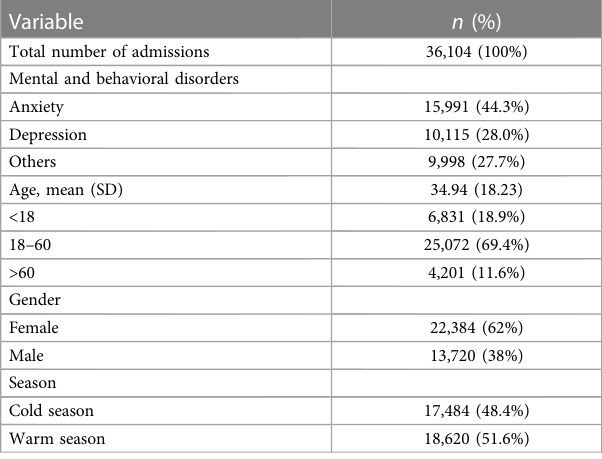
TABLE 1 Characteristics of daily hospital admissions for mental and behavioral disorders in Shenyang from 2017 to 2019.